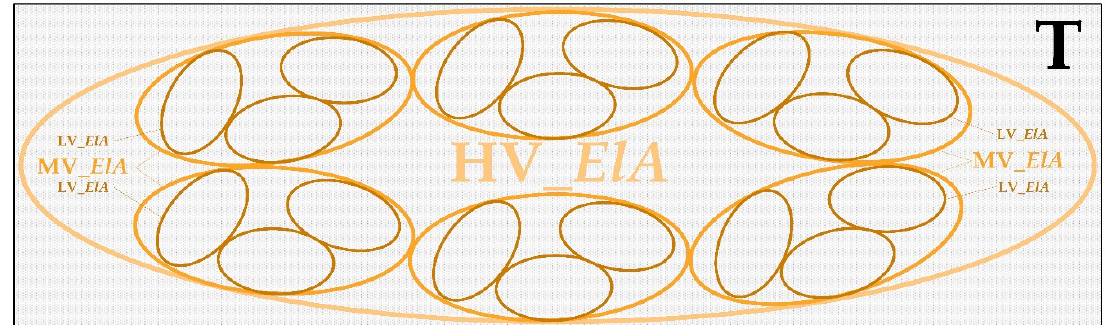
Figure 5. The fractal set of HV and medium voltage graphs (MVGs).